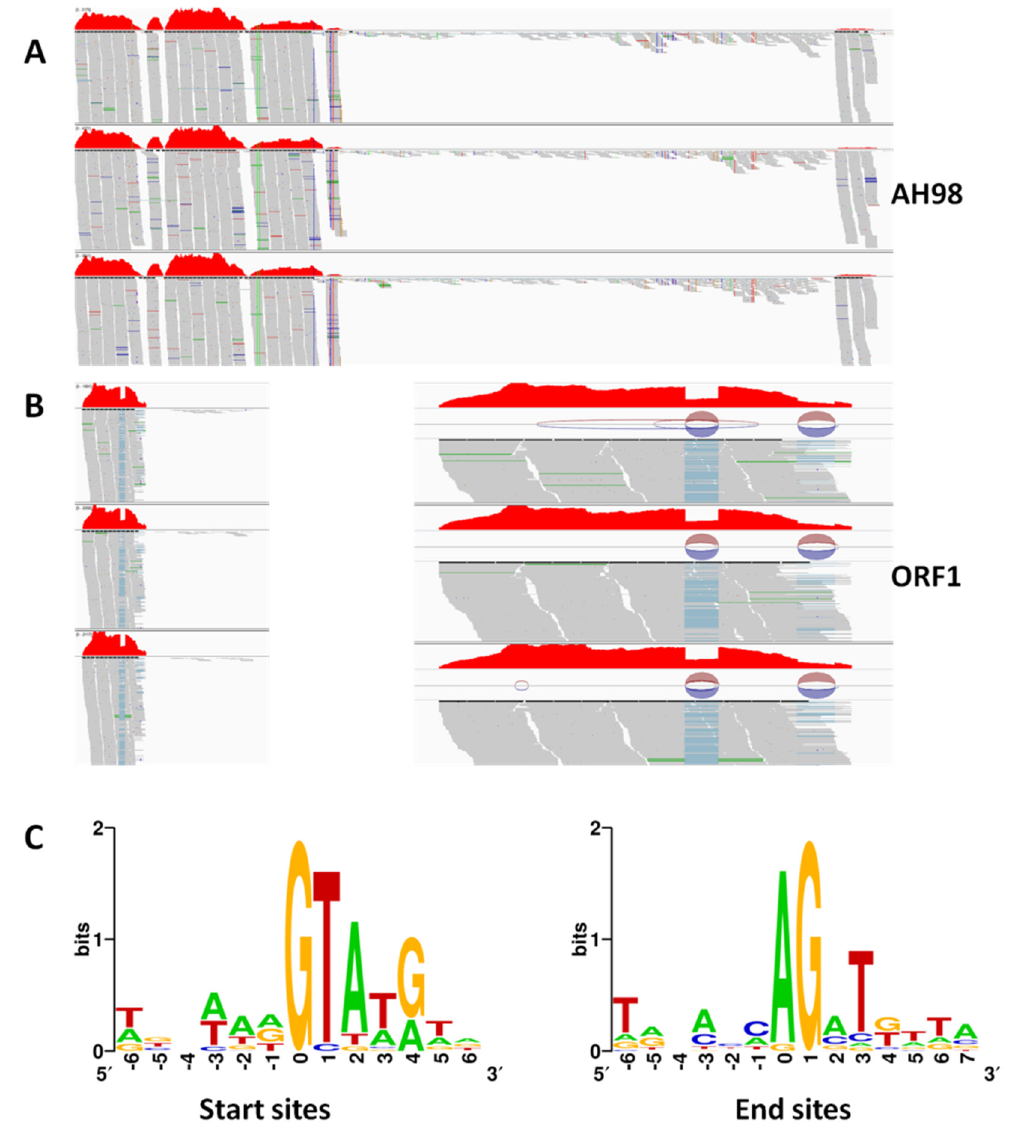
Figure 4. Transcriptions of viral Open Reading Frames ( ORFs ). Clean reads obtained by transcriptome analysisweremappedtoSsNSRV-1genomebysoftwareIGV(http: // www.igv.org / ). ( A )Thetranscription of ORF I in strains AH98. ( B ) The sequence analysis of splicing sites of ORF I mRNA in the mutant strains Z1-1. The number of clean reads matching to two fragments inside ORF I was much less than the other regions. Multiple transcripts were detected in the mutant strain Z1-1. ( C ) Splicing fragments starts at the GT-rich sites and ends at the AG-rich sites. The blue line indicates the regions where the transcriptome data cannot match. The circles represent splice junctions.